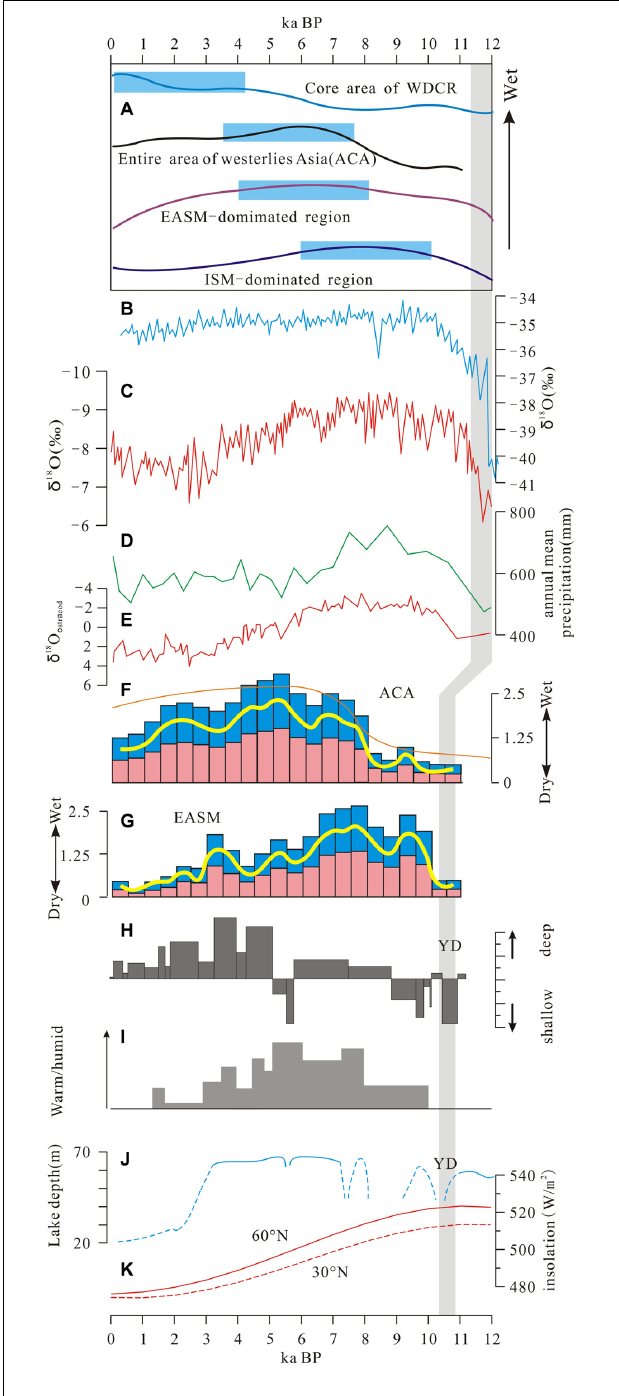
FIGURE 6 | Paleoenvironmental records in different climate regions. (A) westerlies-dominated climatic regime (WDCR), ACA, Eastern Asian Summer Monsoon (EASM), and Indian Summer Monsoon (ISM) (Chen et al., 2019), (B) GRIP (Greenland Ice-core Project (GRIP) Members, 1993), (C) Dongge Cave (Dykoski et al., 2005), (D) Luochuan Loess (Zhou et al., 2014), (E) Qinghai Lake (Liu et al., 2007), (F) Central Asia (ACA) westerly dominated region (Guo et al., 2014), (G) Eastern Asian Summer Monsoon (EASM)-dominated region (Guo et al., 2014), (H) Tengger Nur (this paper), (I) Daihai (Xiao et al., 2004), (J) Daihai (Sun et al., 2009), (K) solar irradiation in the Northern